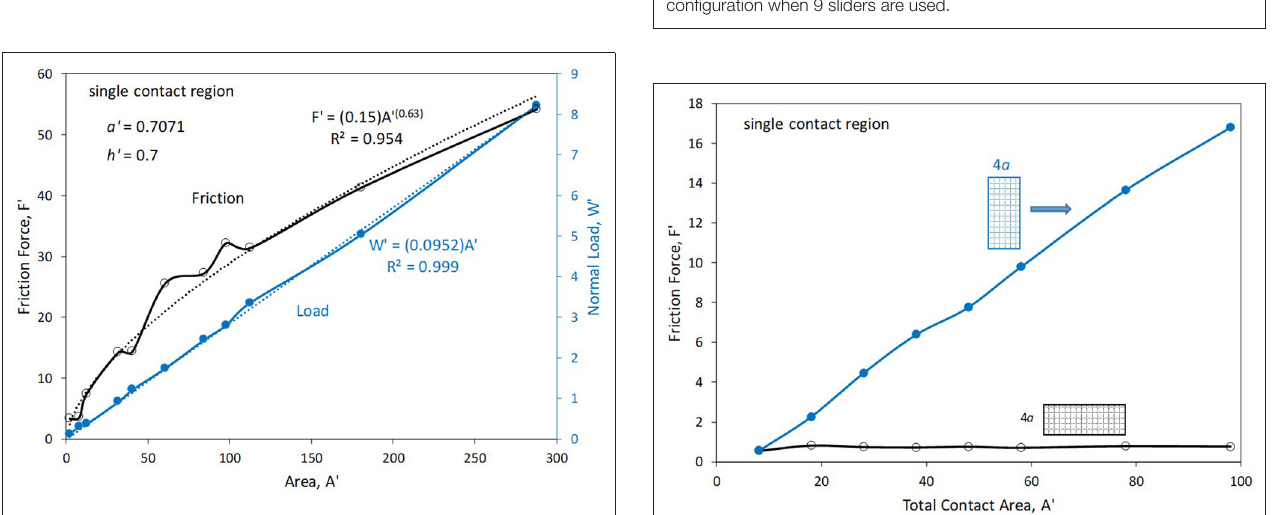
FIGURE 4 | Friction force vs. normal load along with the associated vertical separation. Slider is composed of a 4 4 grid of particles. ×